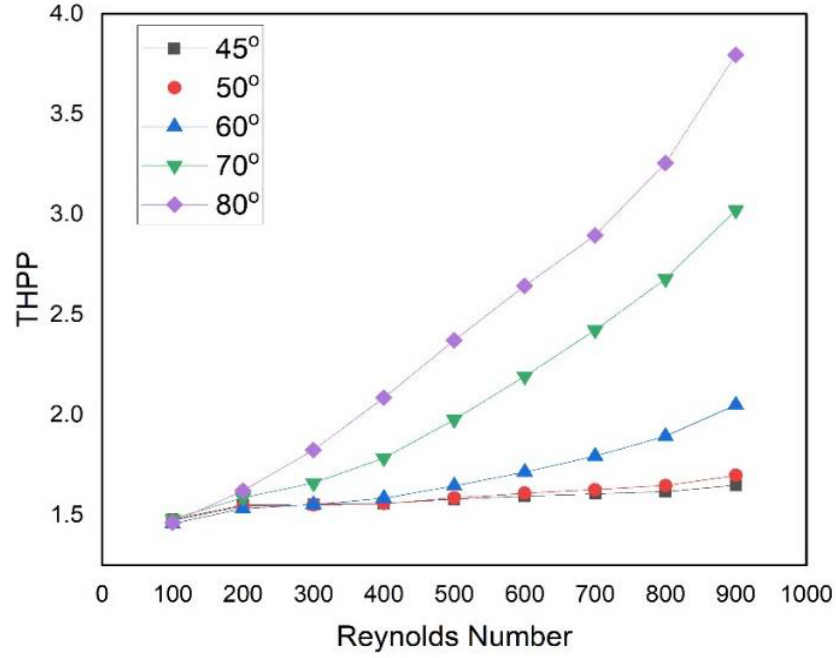
Figure 16. Dependence between THPP and the Reynolds number.